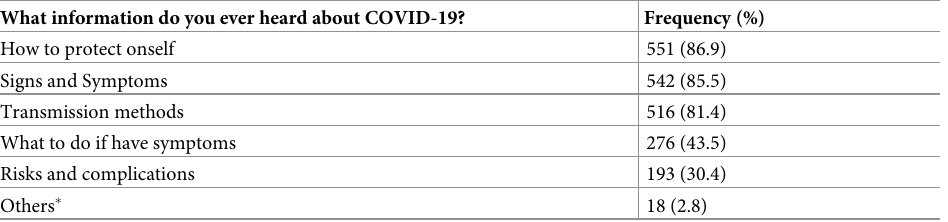
Table 2. Exposure to information on COVID-19 in Qellam Wallaga Zone, Oromia, Ethiopia, 2020. What information do you ever heard about COVID-19?